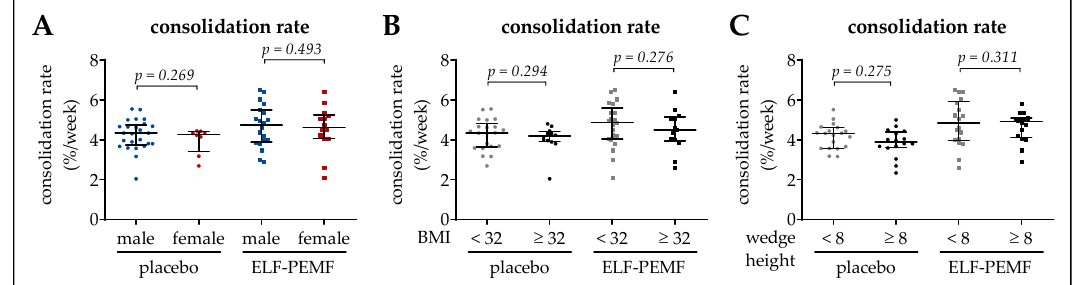
Figure 5. Effect of sex, BMI and wedge height on the osseous consolidation. ( A ) Sex effect on the rate of osseous consolidation. ( B ) A BMI of 32 kg/m 2 was set as inflection point to investigate the effect of BMI on the consolidation rate. ( C ) A wedge height of 8 mm was set as inflection point to investigate the effect of the wedge height on the consolidation rate. Data are represented as scatter diagrams (mean ± 95% CI). Two-tailed Mann–Whitney U -test was used to determine p -values, as indicated. N = 68 data points (geometric mean of n = 3) were used for the individual analyses.